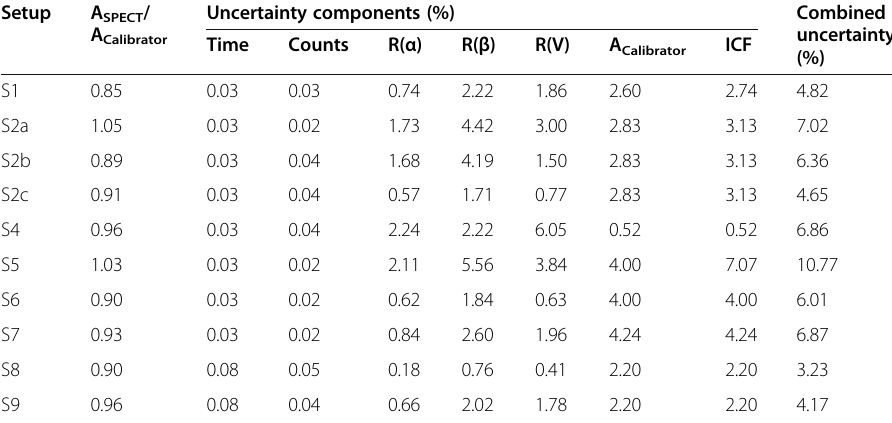
Table 8 Uncertainty budget for spleen activity ratios (A SPECT : SPECT-based activity, A Calibrator : radionuclide calibrator-based activity, R( α ) / R( β ) / R(V): uncertainty components introduced by the recovery originating from α , β and V,